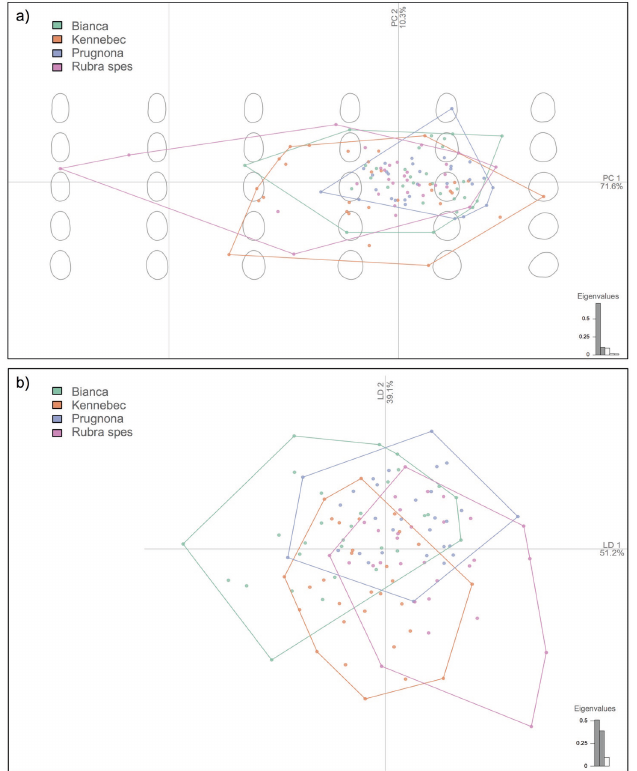
Fig. 2: PCA biplot (a) resulting from outline analysis of the tubers of the four genotypes and linear discriminant analysis of principal com- ponents (DAPC) biplot (b). Grey figures in the background (a) show reconstructions of tuber shape according to each position in the multidimensional space.